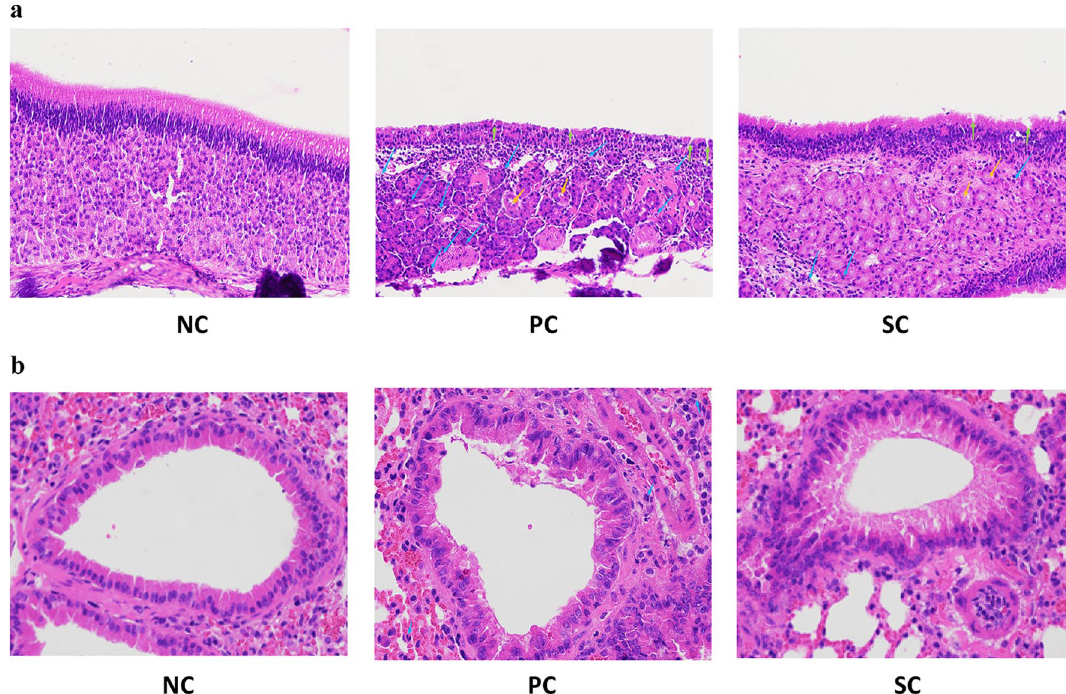
Figure 4. Effects of immunotherapy on histology of nasal mucosa ( a 200×) and lung tissue ( b 400×) in AR mice. The pathological changes of the nasal mucosa and lung tissue were observed by HE staining (the green arrows indicate epithelial damage, the orange arrows indicate glands, the blue arrows indicate eosinophils).